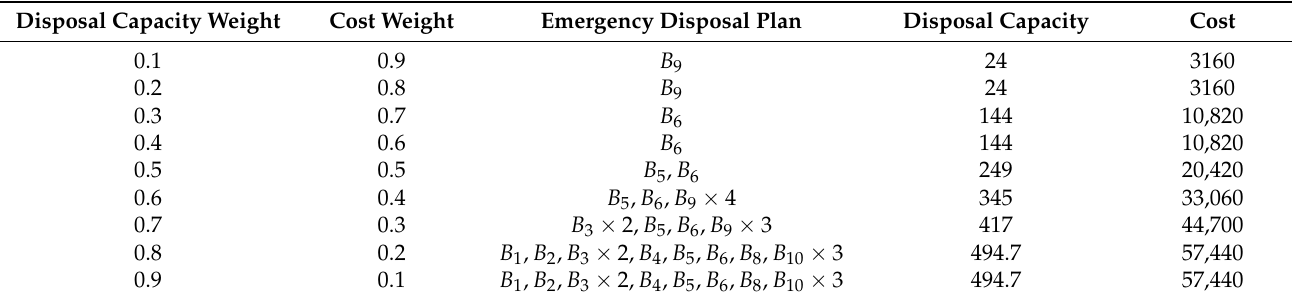
Table 6. Different weights of the multi-objective